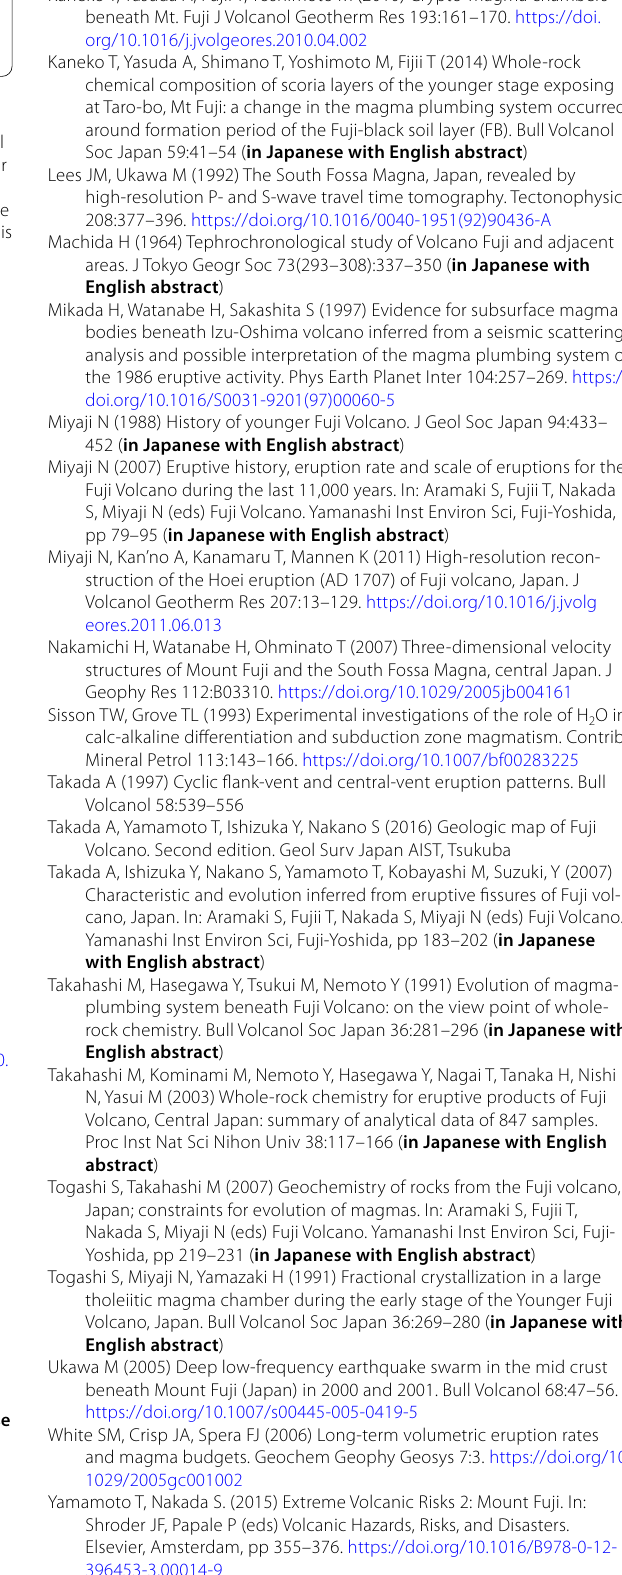
Additional file 2: Figure S1. Harker variation diagrams for the Subashiri- stage products of Fuji Volcano. Figure S2. Chondrite-normalized REE patterns for the Subashiri-stage products of Fuji